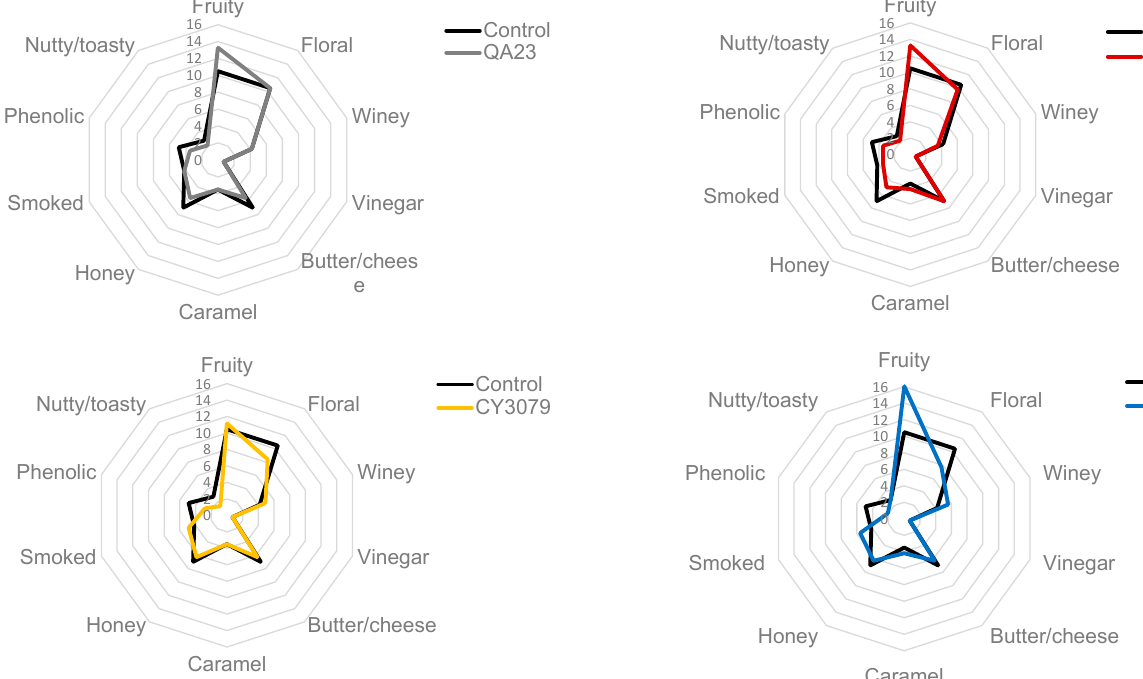
Figure 1. Effect of different yeast strains on the aromatic series of white Fiano wine fermented in barriques. The aromatic series for each of the yeast strain is shown as compared to the control fermentation. The series used in this work groups the odor compounds with similar odor descriptors and reporting as value the sum of the AEDA values, expressed as log 10 , detected by GC/O analysis (Table 2).